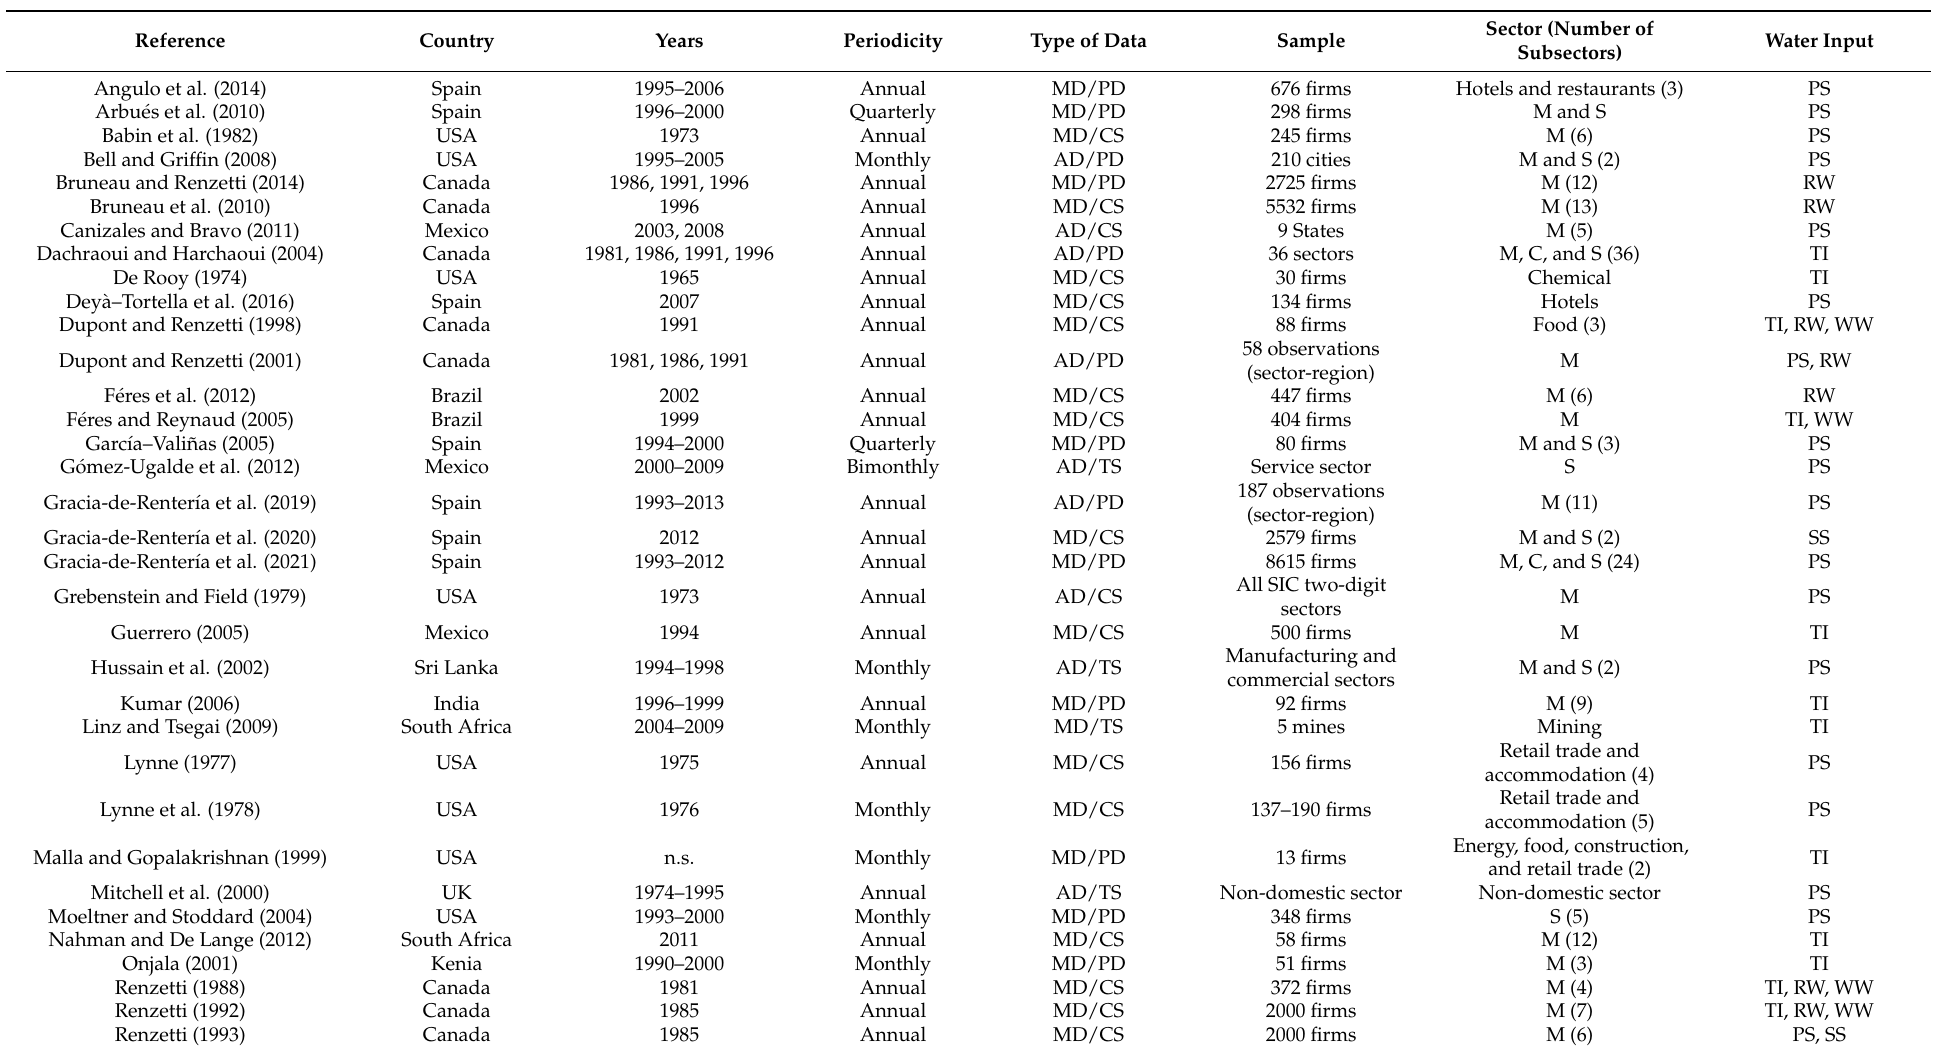
Table 1. Characteristics of